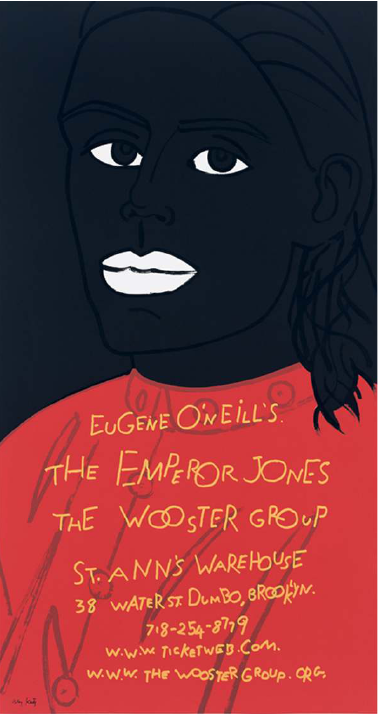
Figure 2: Poster of The Wooster Group’s The Emperor